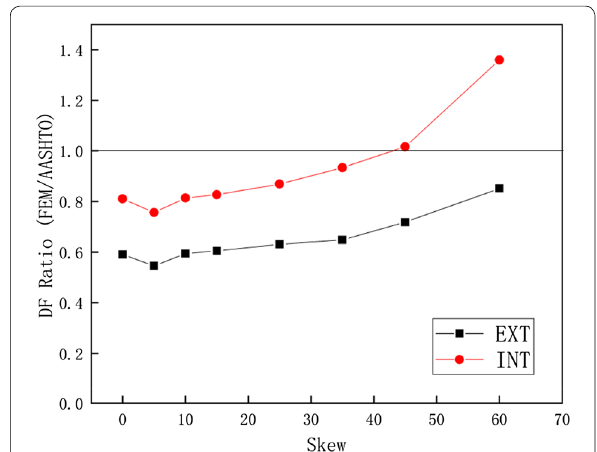
Fig. 16 FEM/AASHTO ratio for skew parameter.